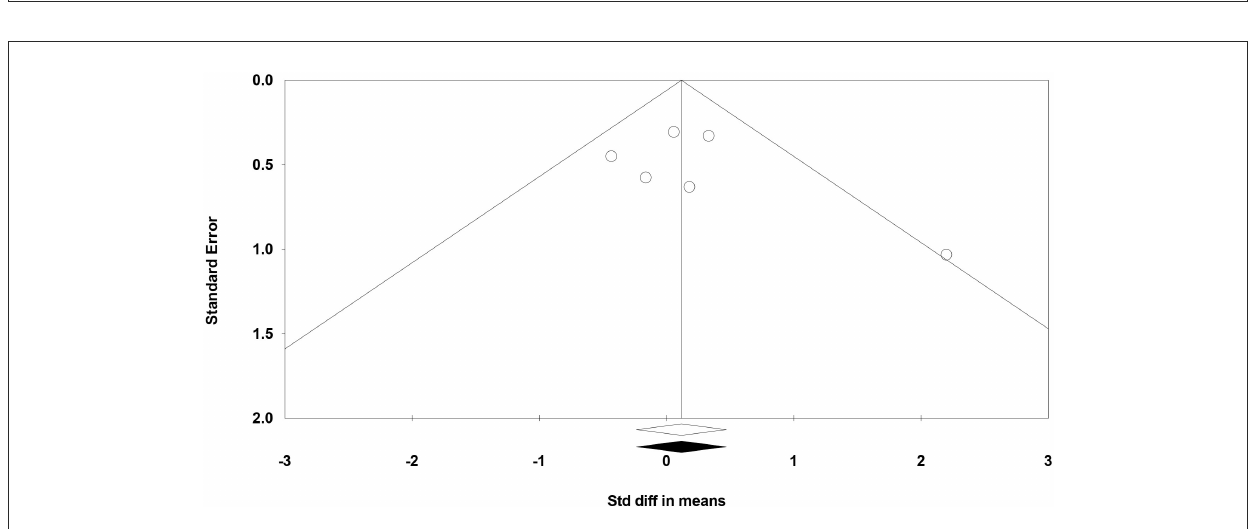
FIGURE3 Funnel plot for the meta-analysis of studies of standard error by the standardized difference in mean cognitive scores.